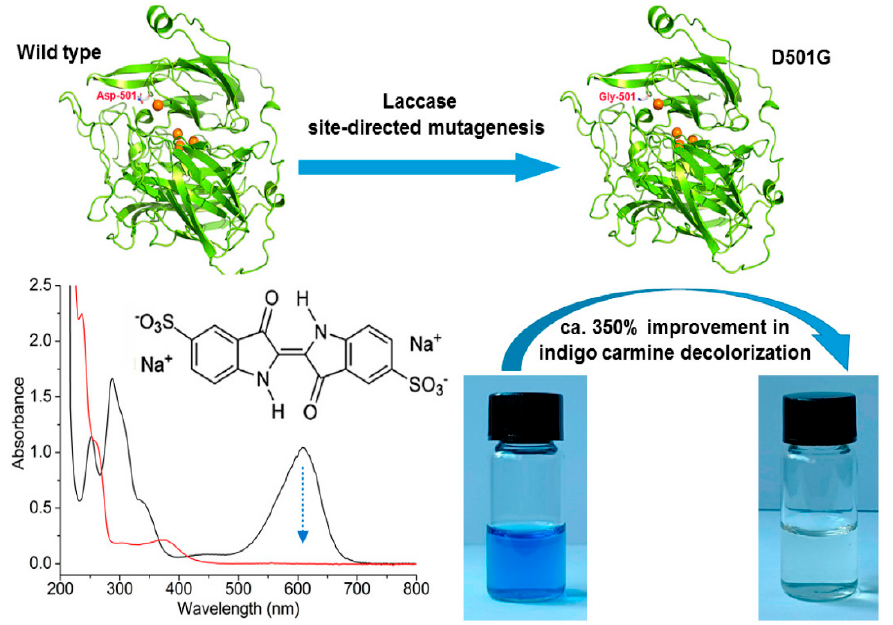
Figure 8. Genetically modified laccase from B. amyloliquefaciens for improving indigo carmine decolorization [135].